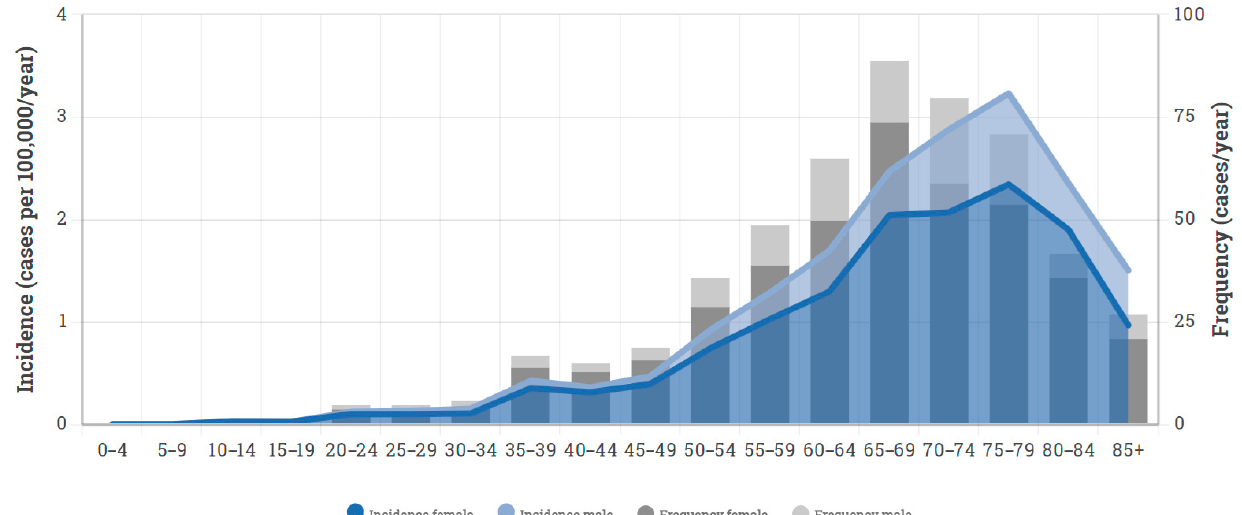
Figure 2. Stacked bar chart and density plot, using data from the Swedish national cancer registry, highlighting the incidence and frequency of spinal meningiomas